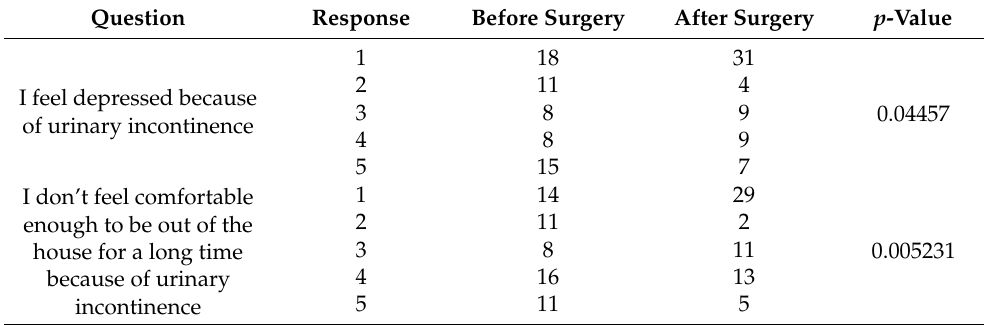
Table 5. Psychosocial impacts responses from IQoL questionnaire from women before and after